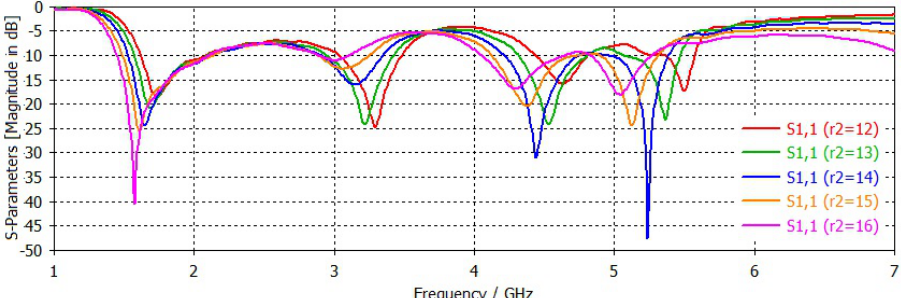
Figure 6. The simulated input reflection coefficient of the antenna for different values of r 2